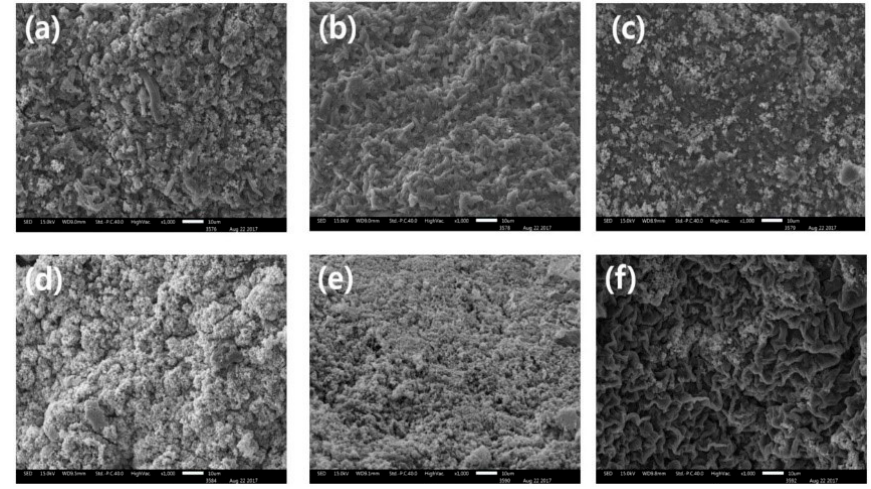
Figure 2. Microstructure of myofibrillar protein with basil seed gum at different salt concentrations